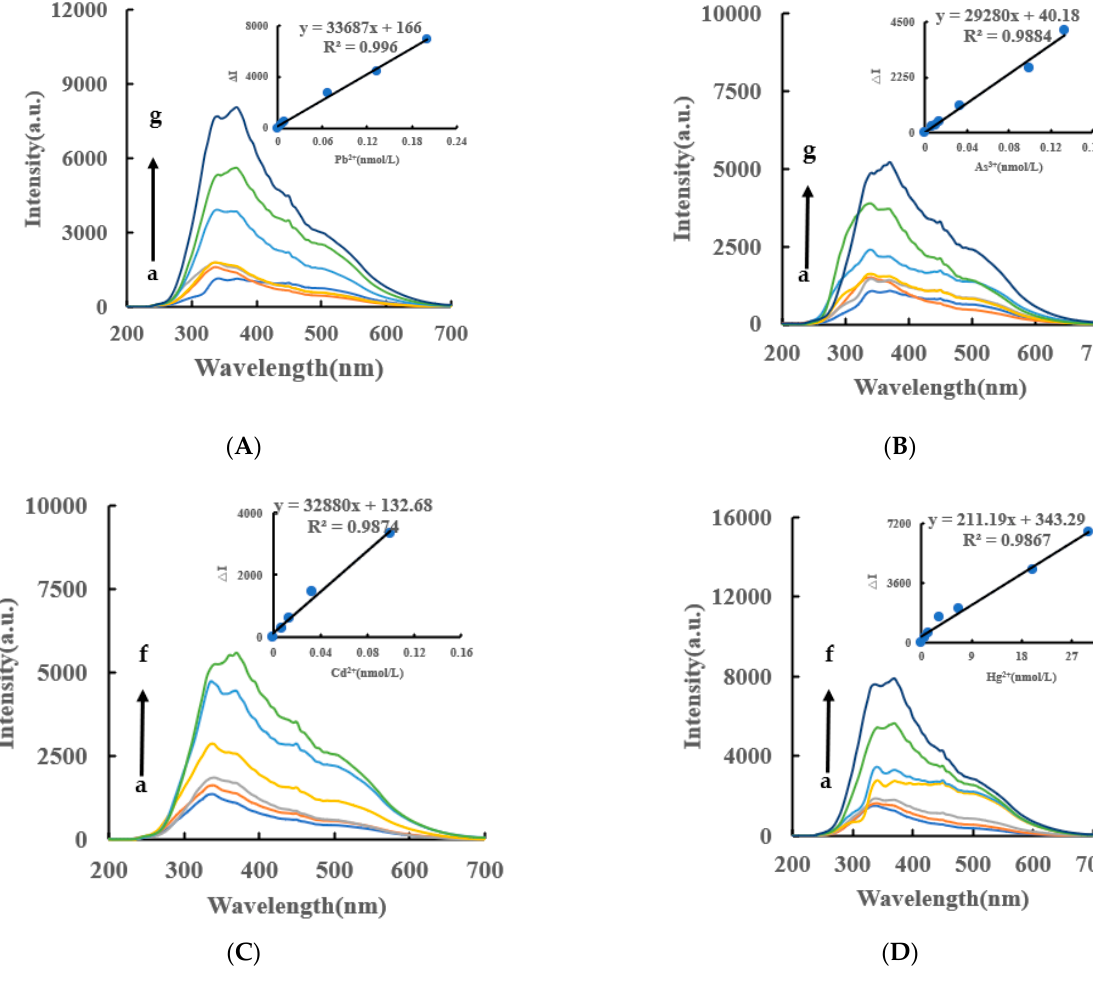
Figure 5. RRS spectra of CB@AgNPs -Fo-AgNO 3 -Apt- inorganic pollutants system RRS spectrum system. ( A ): a-g: (0, 4.47 × 10 − 3 , 6.7 × 10 − 3 , 8.94 × 10 − 3 , 6.7 × 10 − 2 , 0.133, 0.201) nmol/L Pb 2+ + 0.667 nmol/L